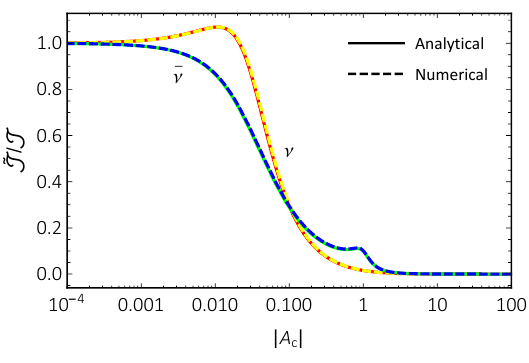
Figure 8 . Analytical and numerical solutions to e J = J in the inverted mass ordering case, where the input parameters and conventions for the curves are the same as